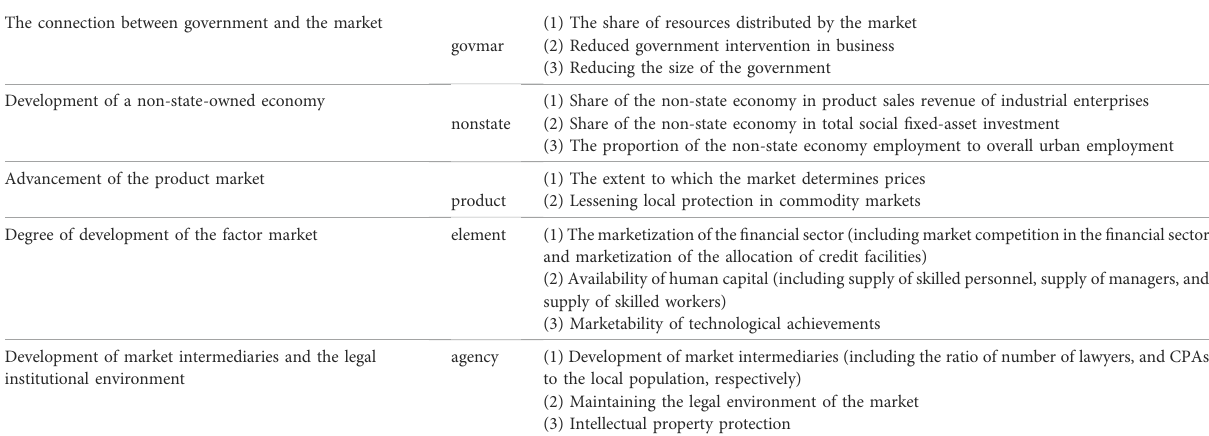
TABLE 1 Business environment indicator evaluation